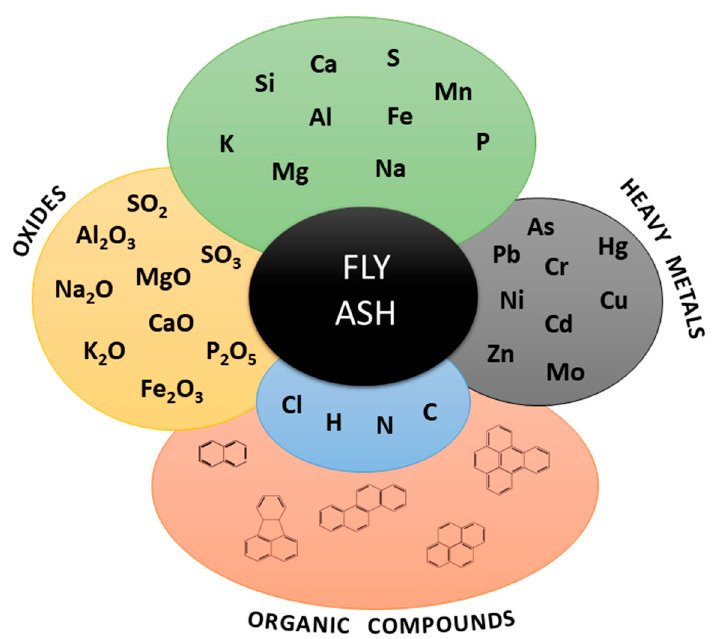
Figure 2. Chemical components of fly ash.